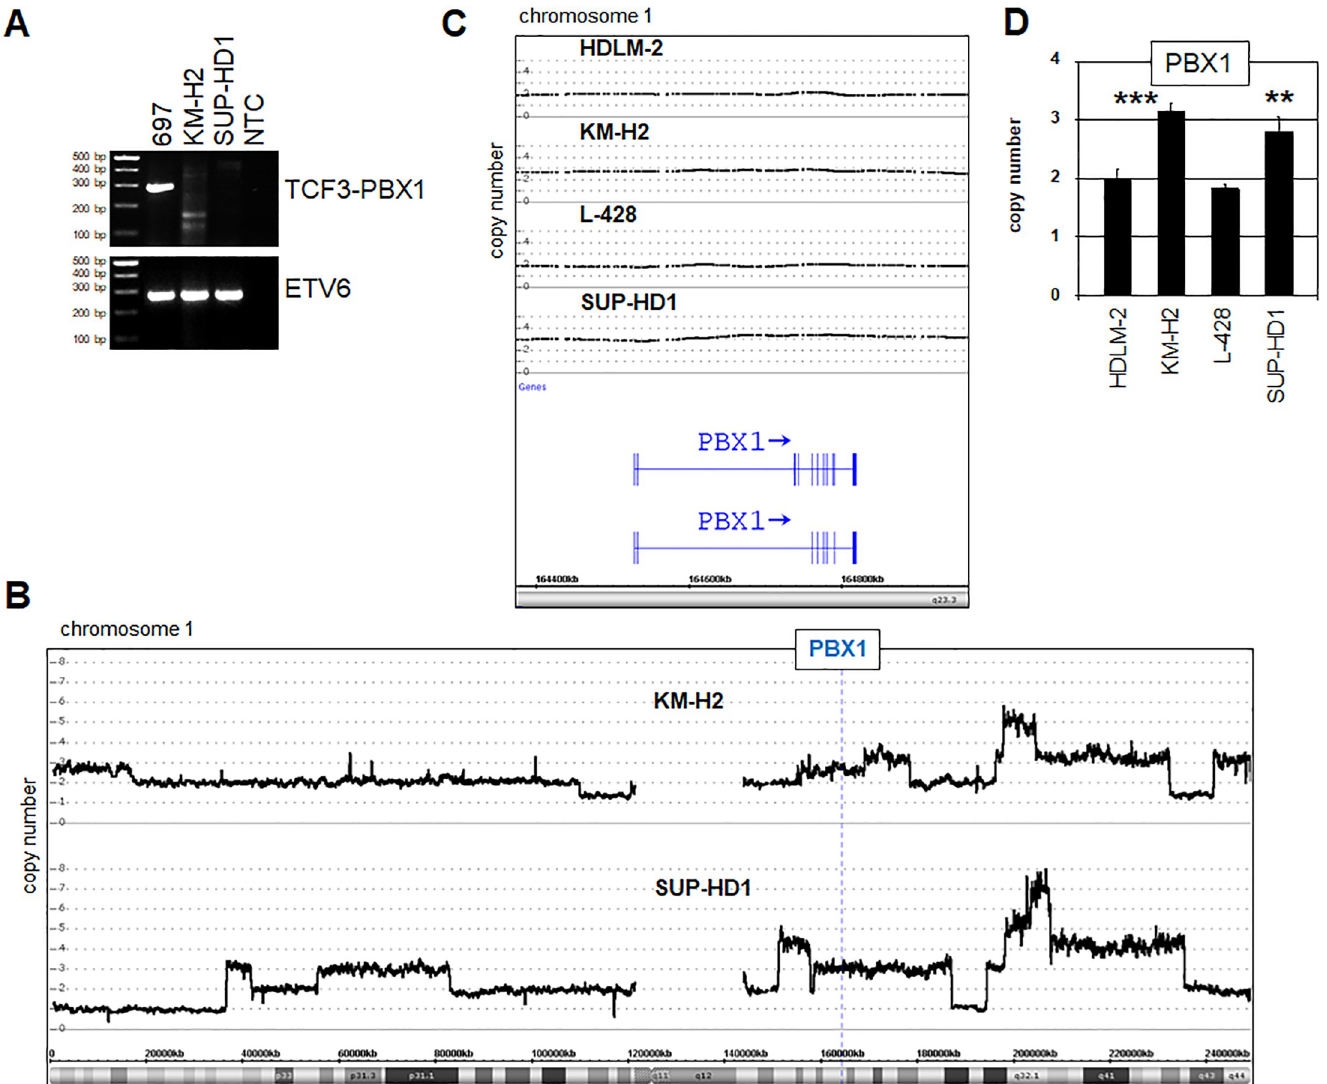
Fig 3. Genomic analyses of the PBX1 locus. (A) RT-PCR analysis of fusion gene TCF3-PBX1 in HL cell lines KM-H2 and SUP-HD1 in addition to pre-B ALL cell line 697 serving as positive control. ETV6 served as control for used cDNA. (B,C) Genomic profiling data of HL cell lines were used to perform copy number analysis for PBX1 located at 1q23. KM-H2 and SUP-HD1 showed three copies while HDLM-2 and L-428 contained two copies. (D) Copy number determination of PBX1 in HDLM-2, KM-H2, L-428 and SUP-HD1 by